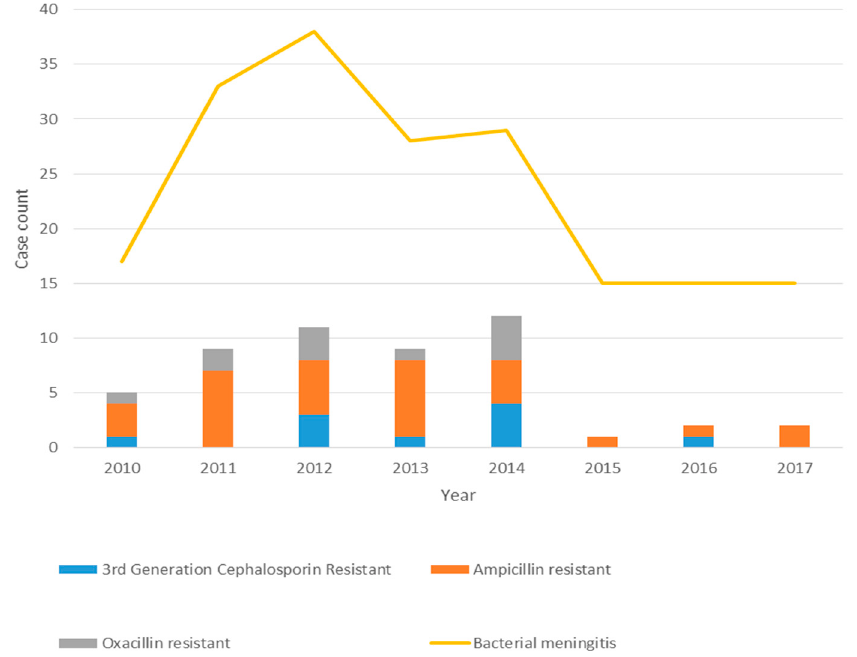
Table 4. Gram-negative bacterial antimicrobial resistance.